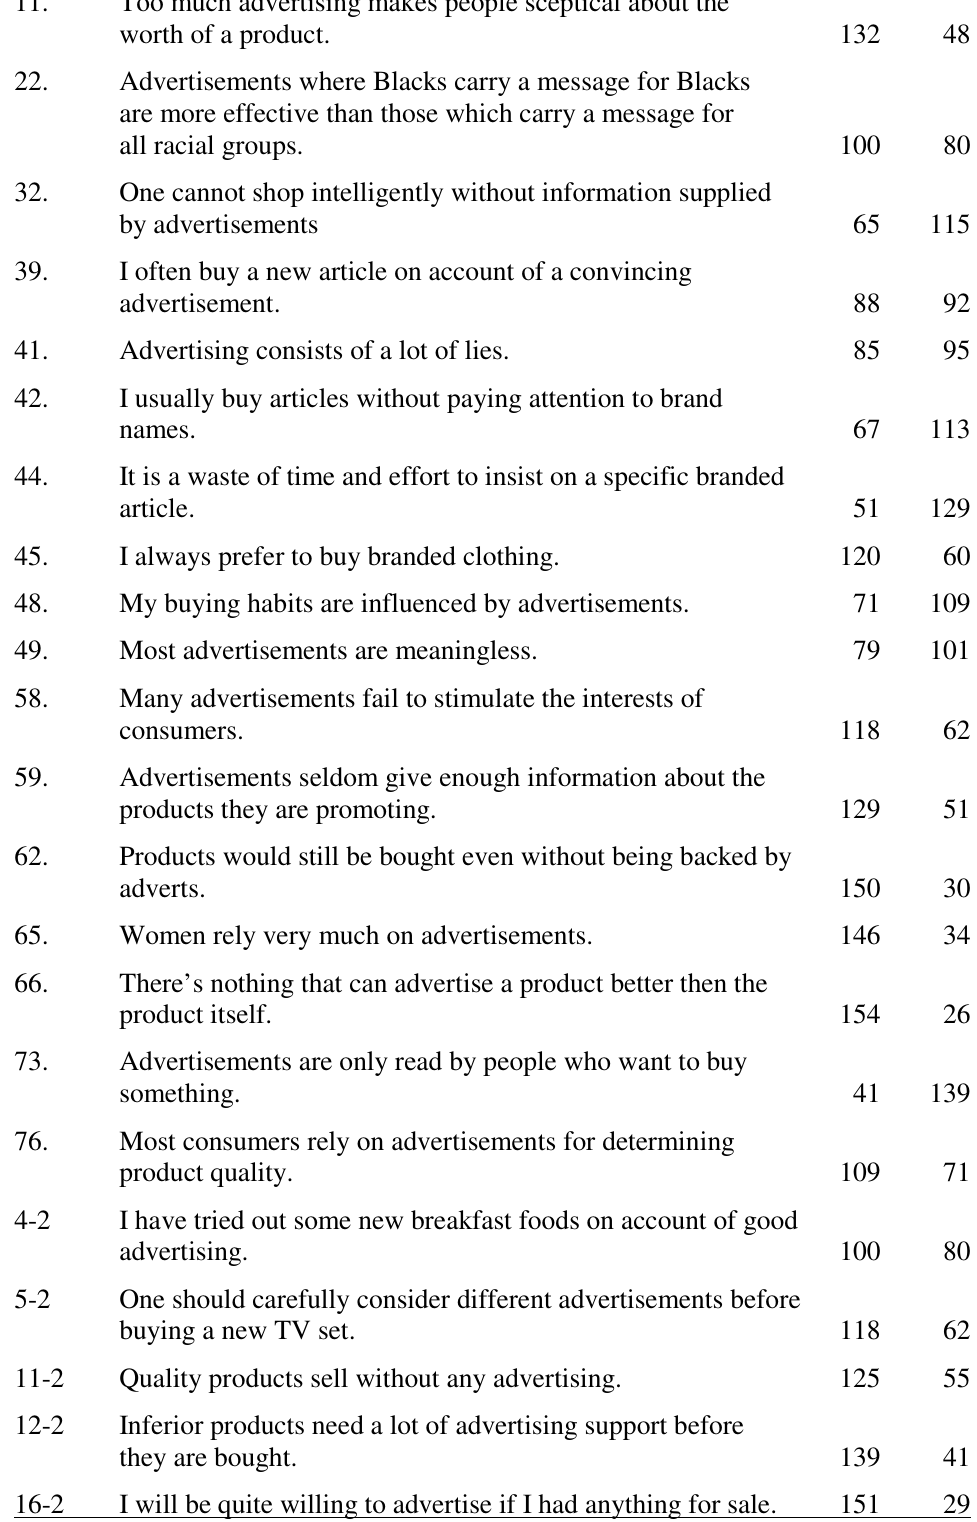
ITEMS REFLECTING AN ATTITUDE ON THE EFFECTIVENESS OF